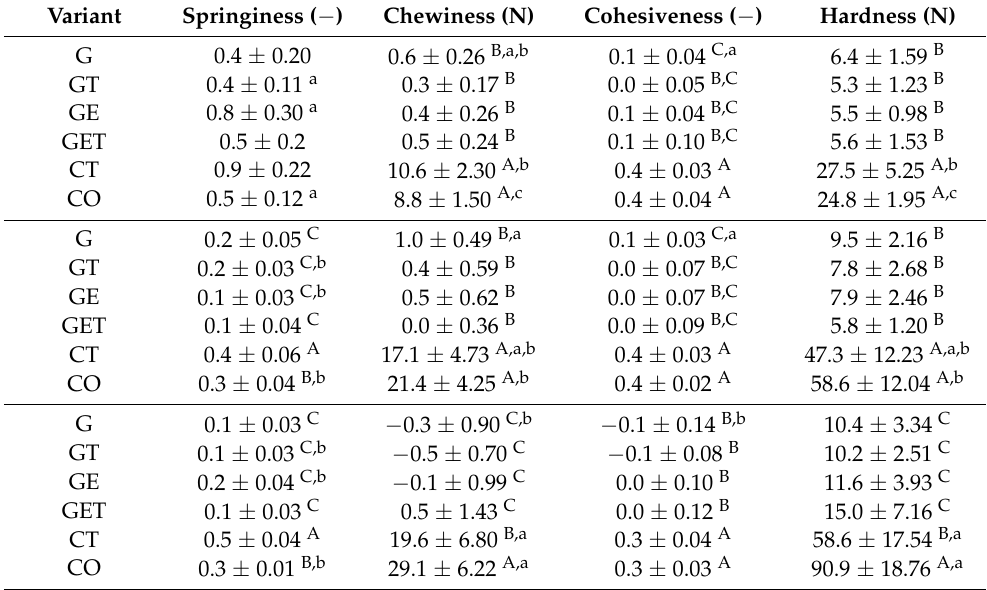
Table 5. Effect of a hydrogel emulsion with capsulated safflower oil, açai extract, and linseed flour as a fat substitute, on texture parameters (TPA) of grilled burgers at 0, 4, and 8 days of